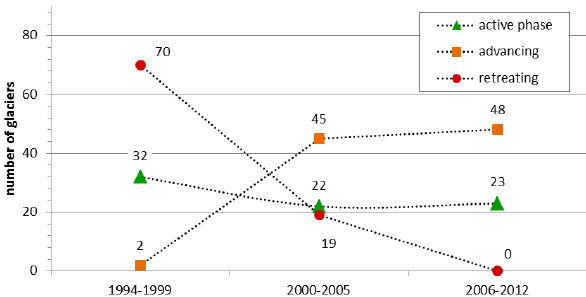
Figure 4. Temporal course of advancing and retreating glaciers, as well as glaciers in the active phase of a surge during various time periods. Glaciers were counted repeatedly if advancing, retreating, or active in various time